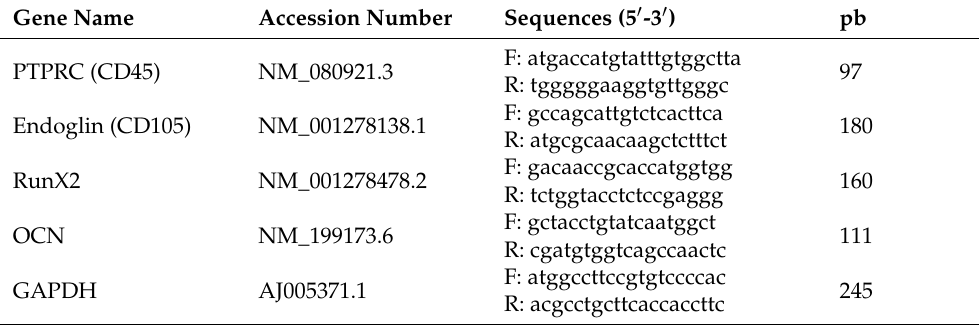
Table 1. Oligonucleotides used for real-time PCR